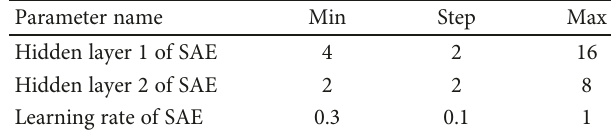
Table 5: Parameters of the SAE model obtained using the method.